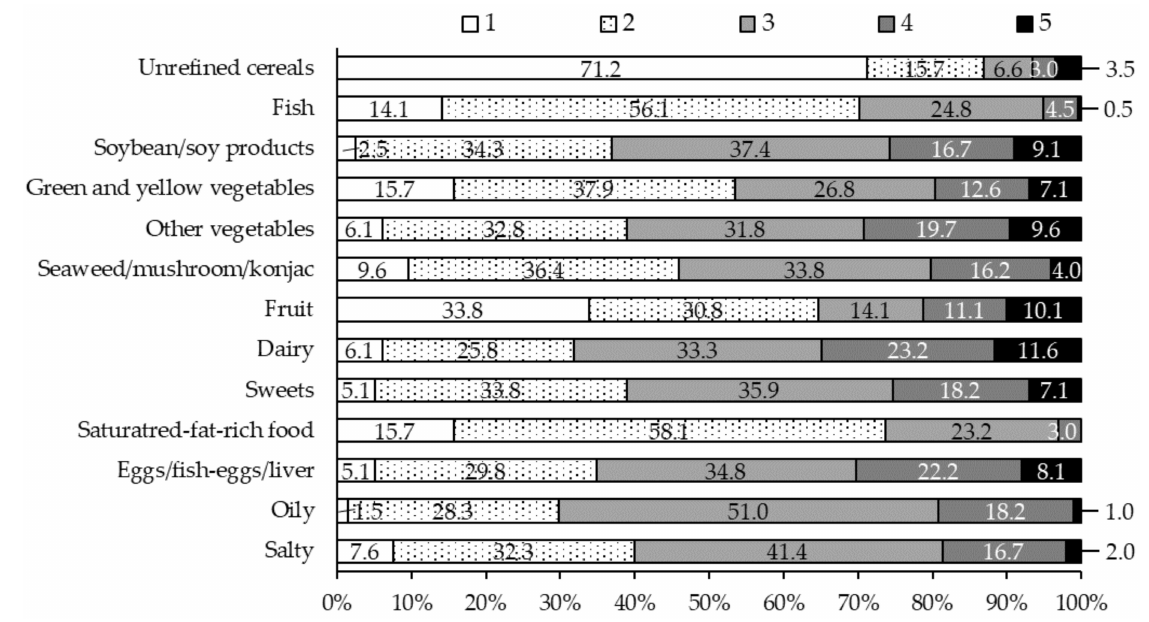
Figure 1. Distribution of food group intake frequency. Frequencies of unrefined cereals, fish, soy- bean/soy products, seaweed/mushroom/konjac, fruit, eggs/fish-eggs/liver were scored as follows: rarely: (1), 1 to 2 times/week: (2), 3 to 4 times/week: (3), 5 to 6 times/week: (4), over 7 times/week: (5). Frequencies of green and yellow vegetables and other vegetables were scored as follows: less than 2 times/week: (1), 3 to 4 times/week: (2), 5 to 6 times/week: (3), 7 to 10 times/week: (4),